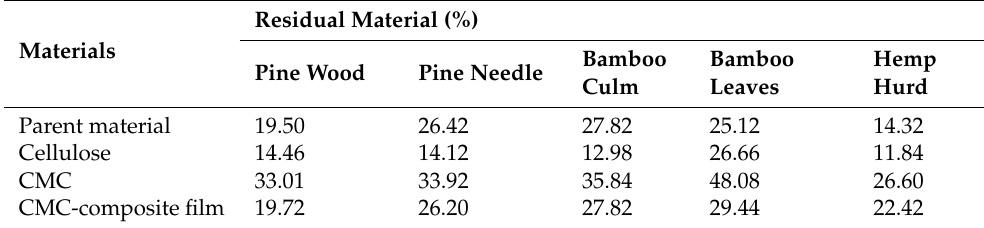
Table 3. Residue remaining (as a % of the original material) after